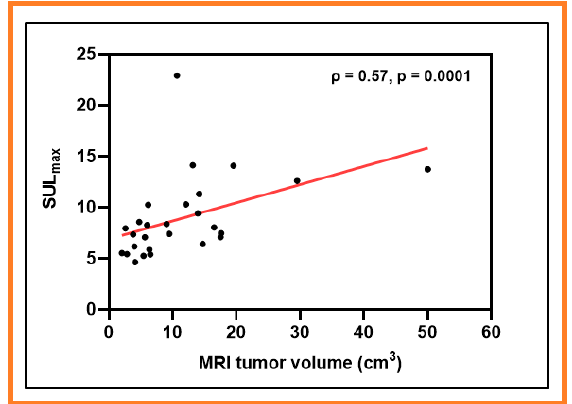
Figure 5. Scatter plot showing a correlation between 18 F-FDG-PET/CT-derived maximum standard- ized uptake value normalized to lean body mass (SULmax) and metastatic lymph node volumes from T 2 weighted MRI (V t- MRI ). Circles represent the data, and the solid line denotes the line of best fit.